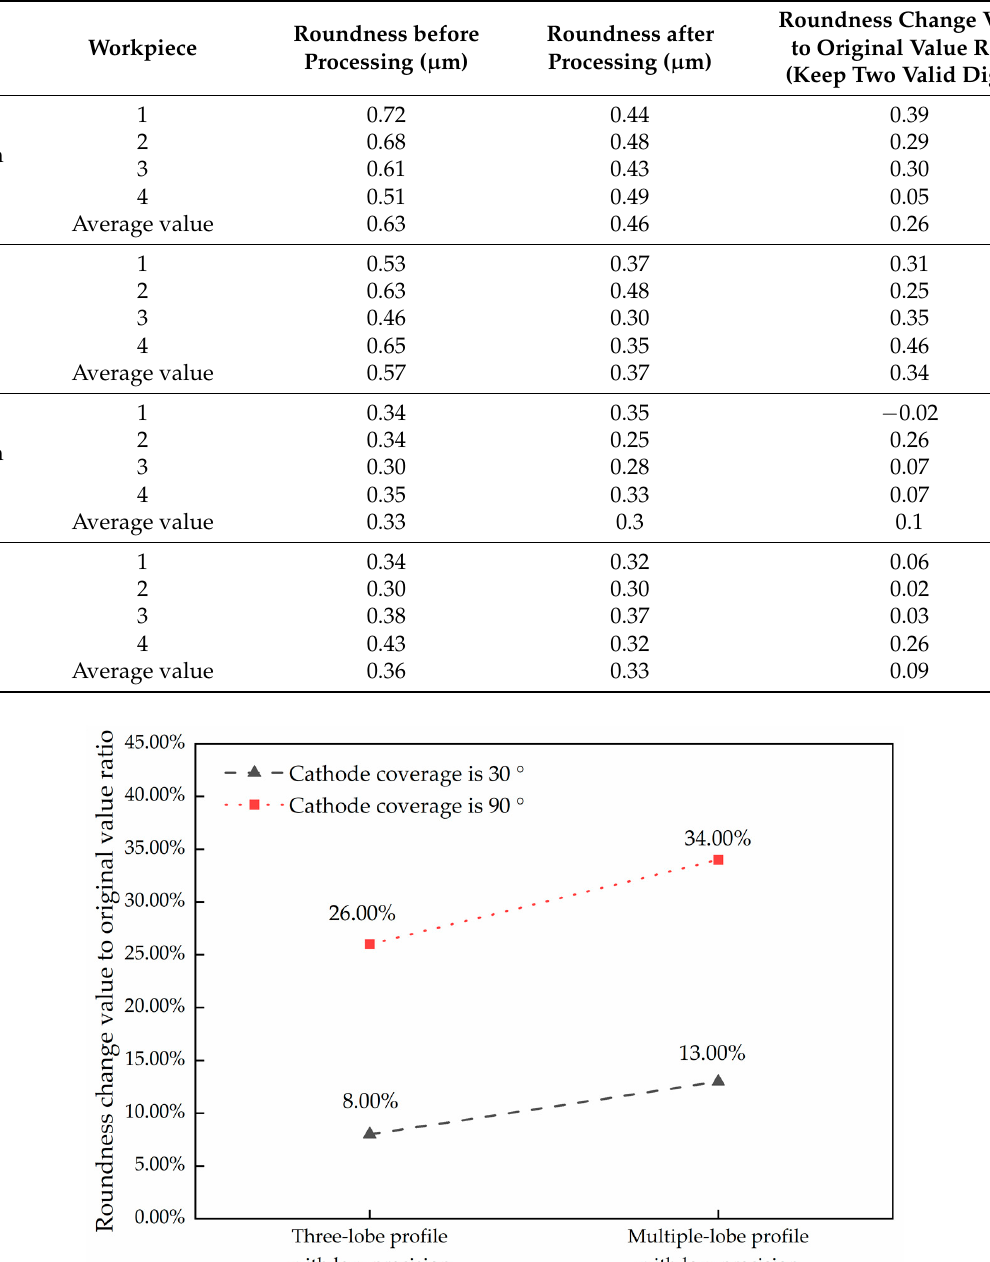
Table 9. Experimental results with 90 ◦ cathode coverage.